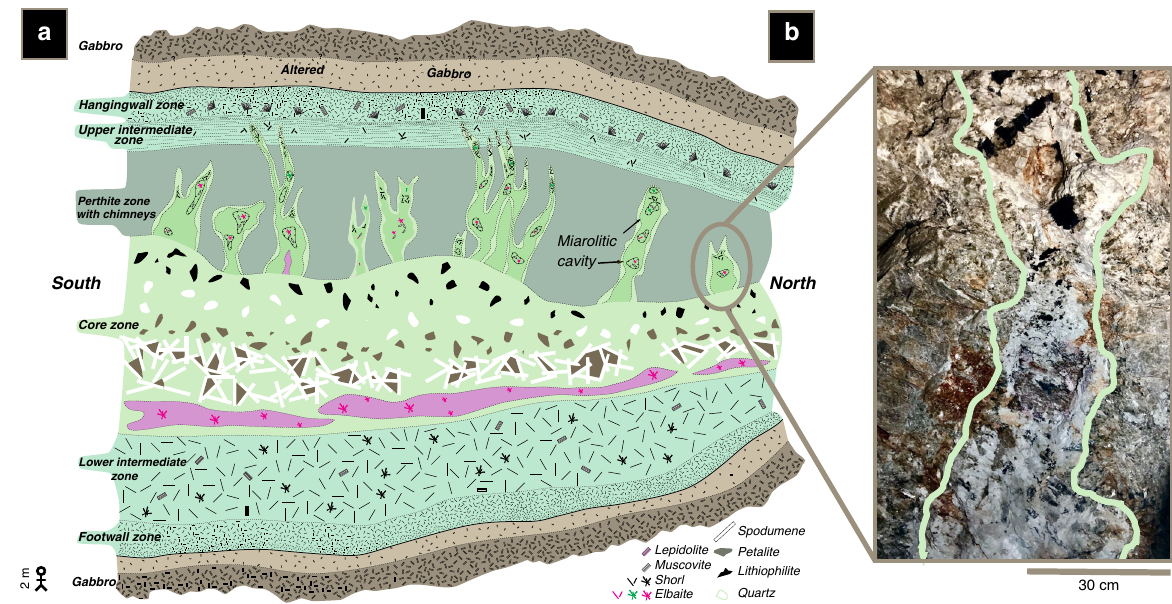
Fig. 1 Cartoon of the Stewart pegmatite with an image of a miarolitic cavity. a Schematic diagram of the Stewart pegmatite modi fi ed from Morton et al. 9 . A 2 m tall person for scale on the lower left. Outer and intermediate zones are granitic in composition. b An example of a small miarolitic cavity (chimney) that propagated from the core zone into the solidi fi ed upper zone. The miarolitic cavity contains tourmaline and quartz crystals set within a fi ne-grained matrix of lepidolite. Lighter margins of the cavity are de fi ned by white albite.